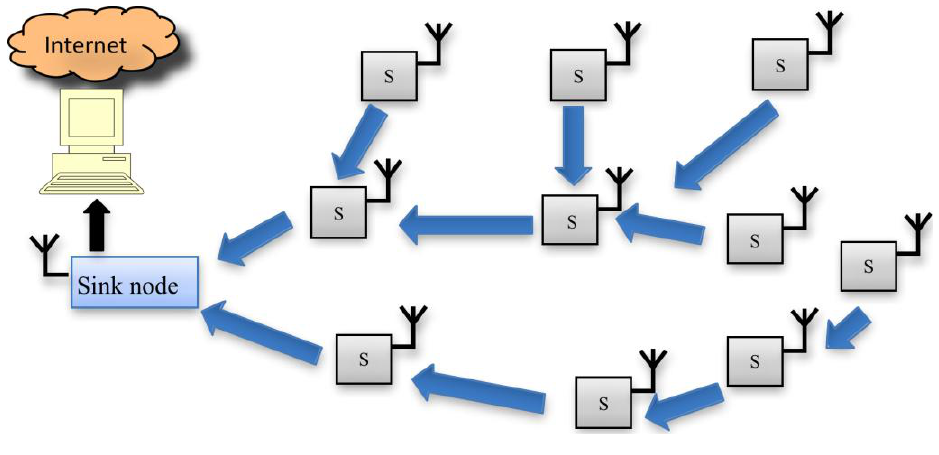
Figure 2. Wireless sensor network (WSN) scheme.